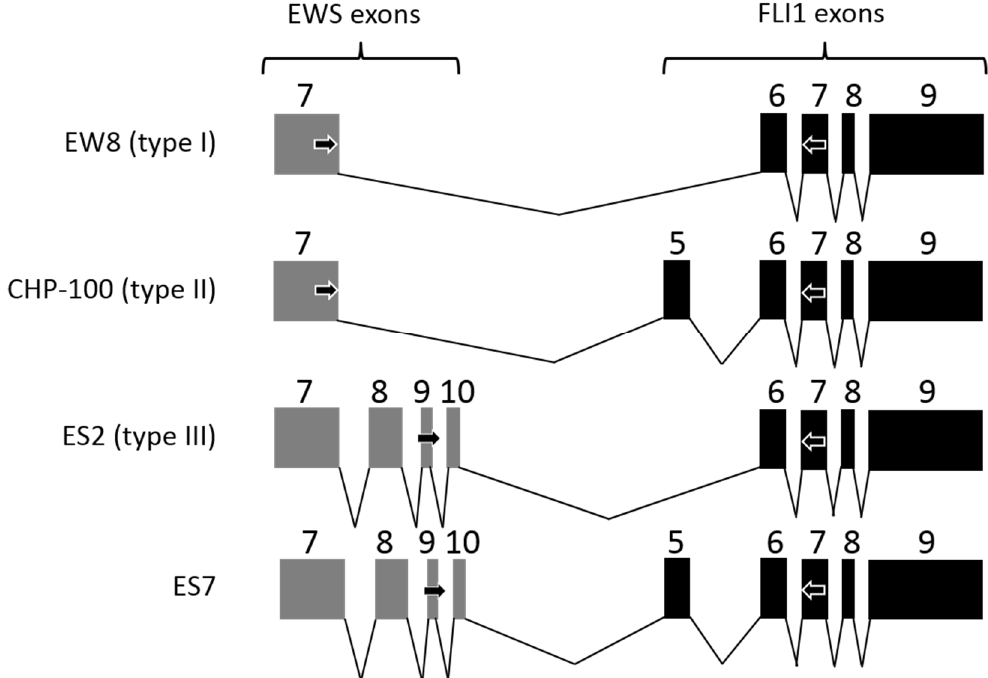
Figure 1. The t(11;22)(q24;q12) chromosome translocation in the ES cell lines. Schematic representation of the t(11;22)(q24;q12) reciprocal chromosomal translocation involving the EWS and FLI1 gene in the four cell lines (EW8, CHP-100, ES2 and ES7) that were used to induce metastatic foci of Ewing’s sarcoma in human ovarian cortex tissue fragments. EW8 contains the most common fusion between the EWS gene exon 7 with FLI1 gene exon 6 (type I). The location of the reverse PCR primer in exon 7 of the FLI1 gene and the two forward primers located in exons 7 and 9 of the EWS gene for the detection of the EWS-FLI1 fusion transcripts are indicated by arrows. CHP, Children’s Hospital of Philadelphia; ES, Ewing’s sarcoma; EWS, Ewing sarcoma breakpoint region 1; FLI1, Friend leukemia integration 1 transcription factor.